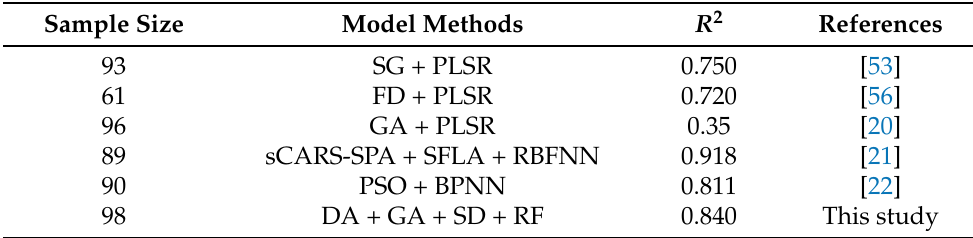
Table 5. Comparison of previous lab-based estimation models of arsenic concentration in bare soils with the satellite-based best-performing DA + GA + SD + RF model from this study.